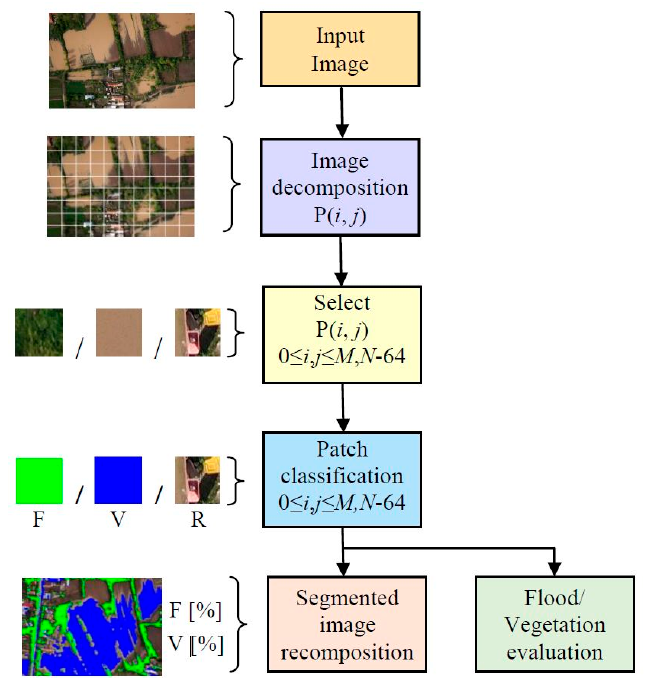
Figure 11. Flow chart of the global system (F—flood class, V—vegetation class, and R—rest class). The meanings of the notations in Figure 12 are the following: I—image to be segmented (input), ID—image decomposition in patches, P i,j —patch of I on ( i,j ) position, PC k —primary classifier (PC 1 — YOLO, PC 2 —GAN, PC 3 —LeNet, PC 4 —AlexNet, and PC 5 —ResNet), p k —probability of P i,j